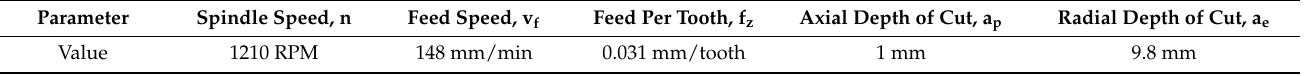
Table 5. Milling process parameters used during experiment.